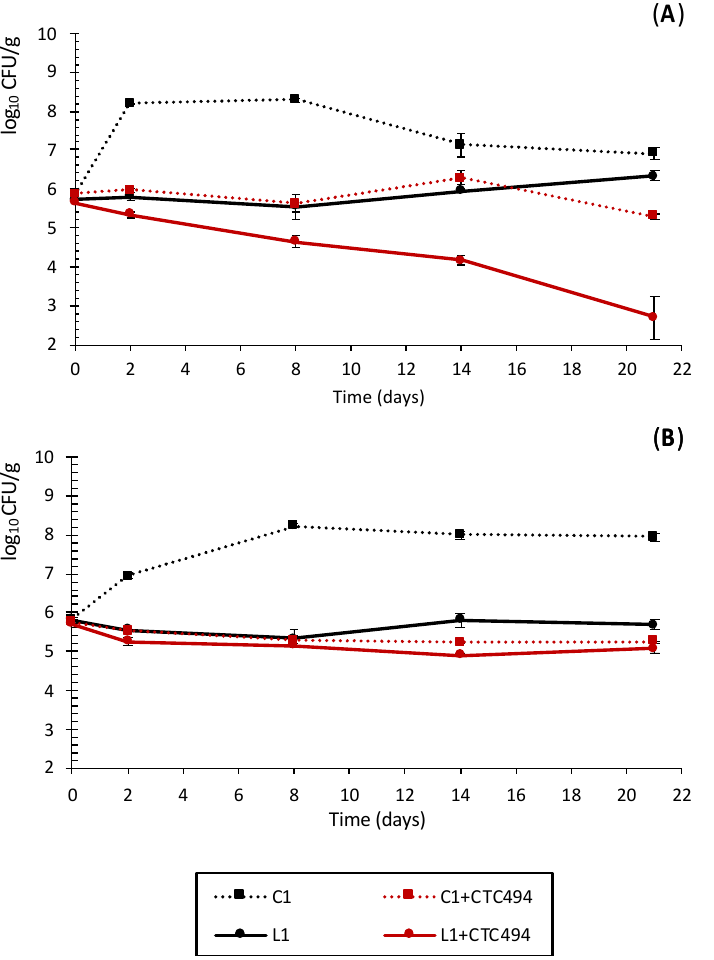
Figure 2. Counts of Salmonella ( A ) and Listeria monocytogenes ( B ) strains in pork sausages spontaneously fermented with (L1) and without (C1) the addition of 5% of cava lees or fermented with the starter culture L. sakei CTC494 with (L1+ CTC494) or without (C1+ CTC494) lees.